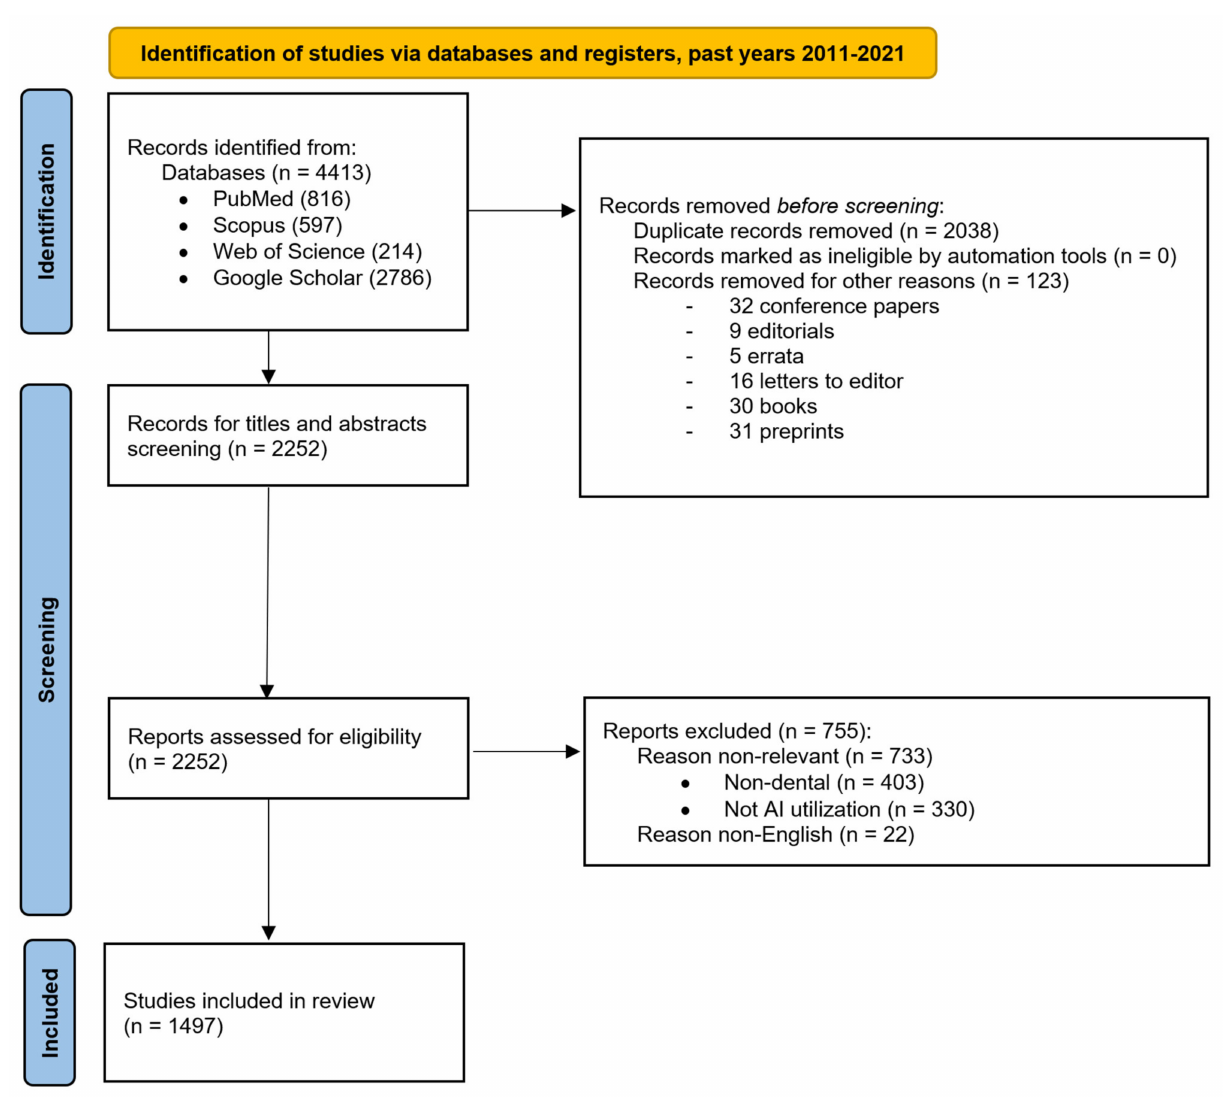
Figure 3. Objective 1: the number of dental publications focused on AI utilization. The PRISMA flow chart diagram depicts the flow of information through the different phases of the systematic review for the first objective. Table 2. Results of synthesis of annual publication counts of AI-focused dental publications from various electronic databases, contrasting registered and finally included series of publications with percentual annual increase